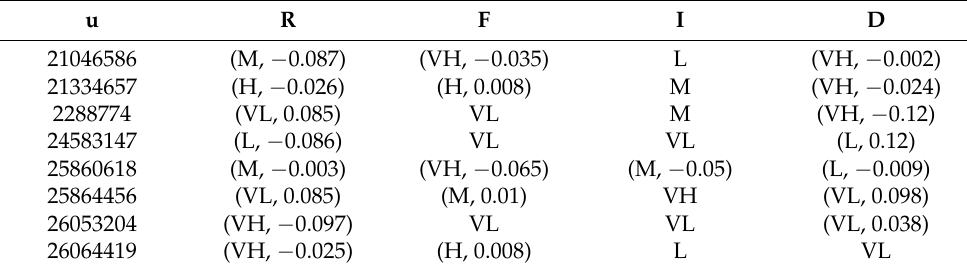
Table 7. Extract of